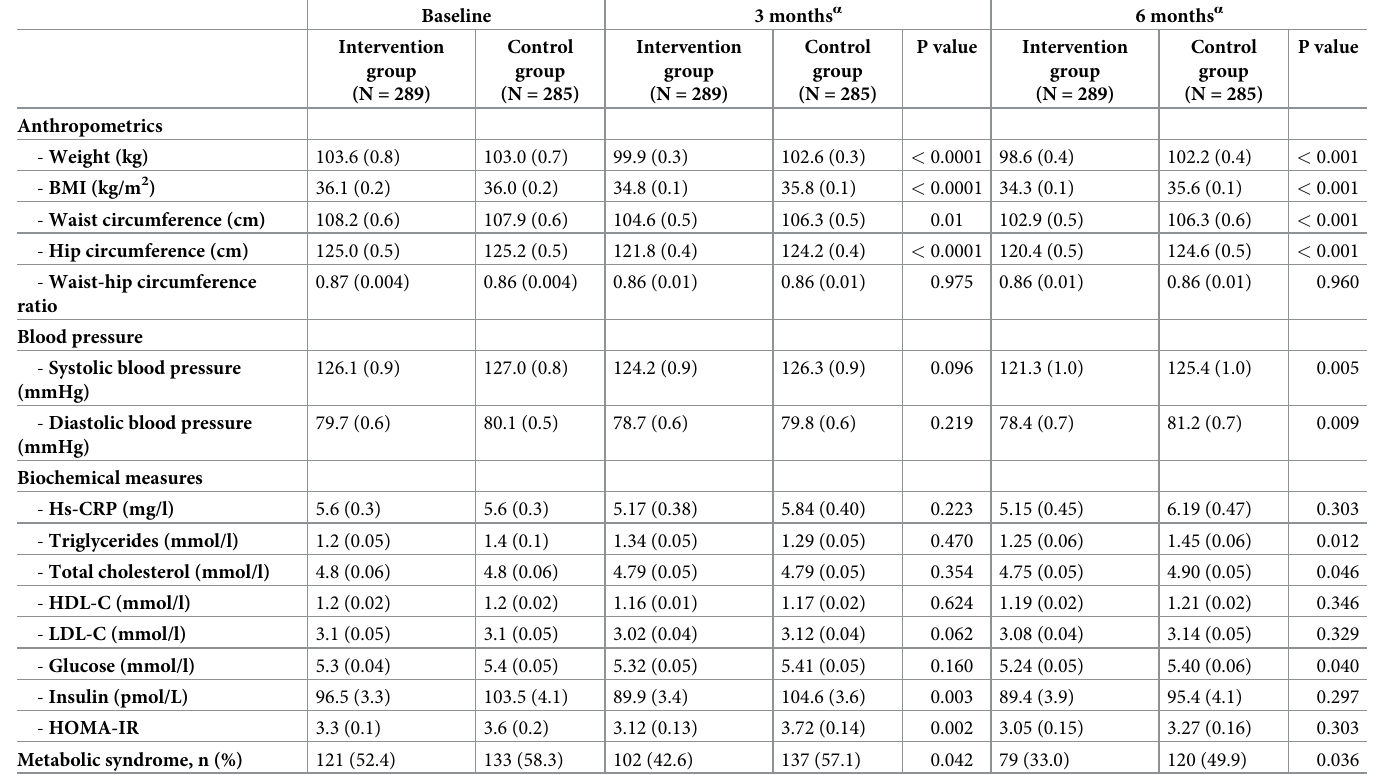
Table 2. Cardiometabolic outcomes at baseline (mean (standard error (SE))), three and six months for the intervention and control group, unless stated otherwise.